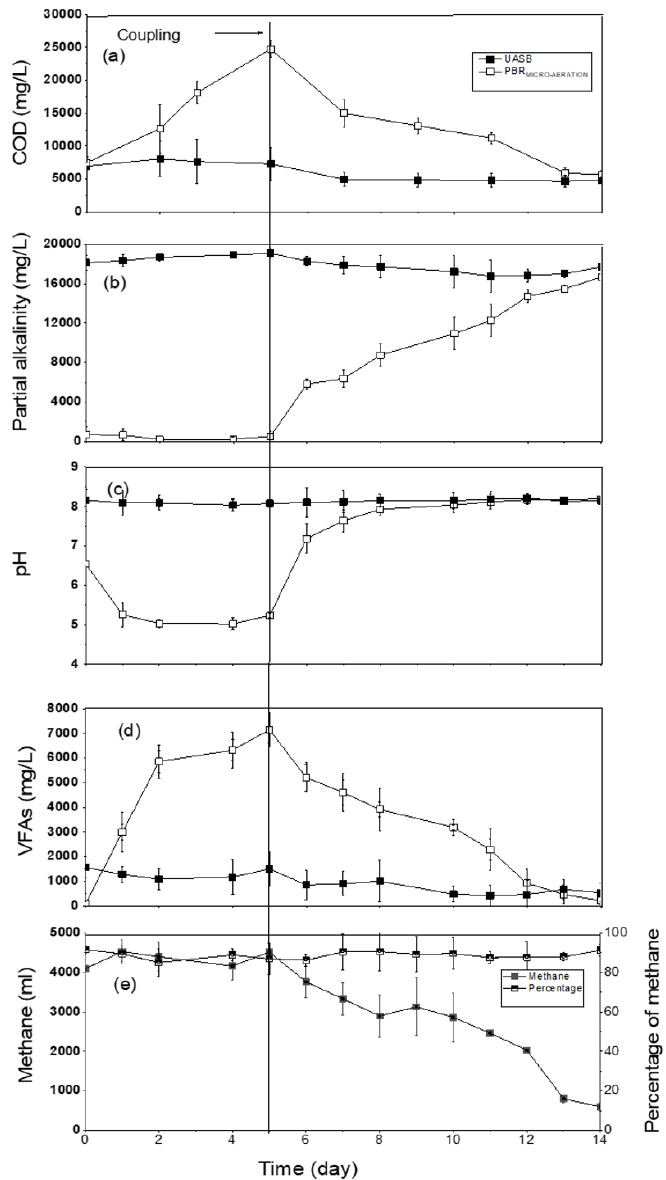
Figure 4. Coupling reactors with 2 kg COD / m 3 d of organic load rate: packed bed reactor with micro-aereation and upflow anaerobic sludge blanket with direct interspecies electrons transfer. ( a ) chemical oxygen demand, ( b ) partial alkalinity, ( c ) pH, ( d ) volatile fatty acids and ( e ) mL of methane and percentage of